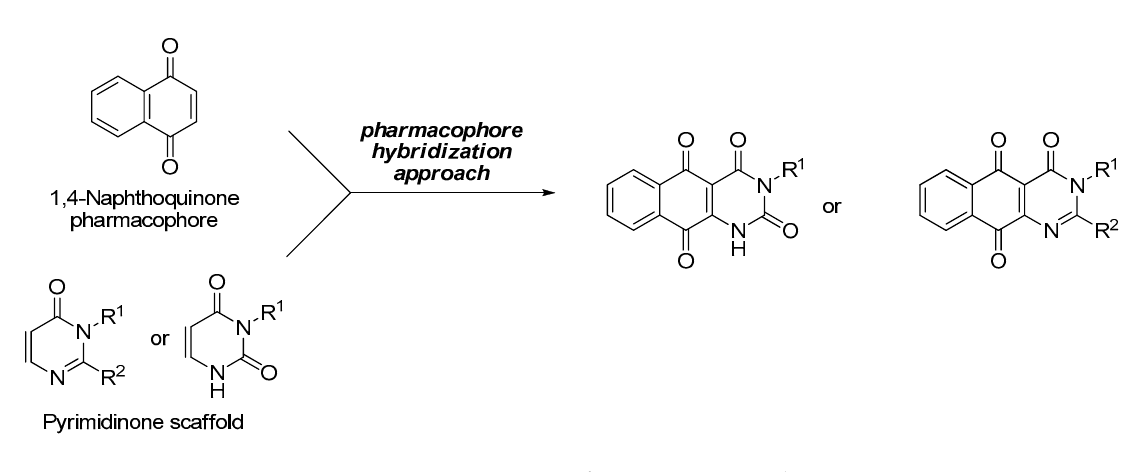
Figure 1. Design strategy for target compounds.